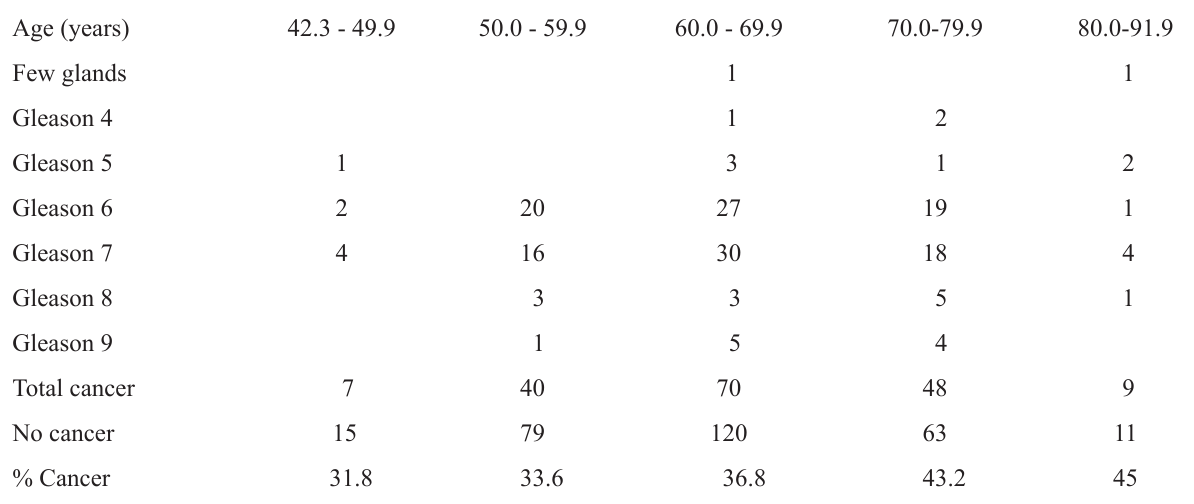
The risk of prostate cancer increased with age odds ratio 1.03 (95% CI = 1.02 to 1.05, p=0.0003). The odds ratio is multiplicative and